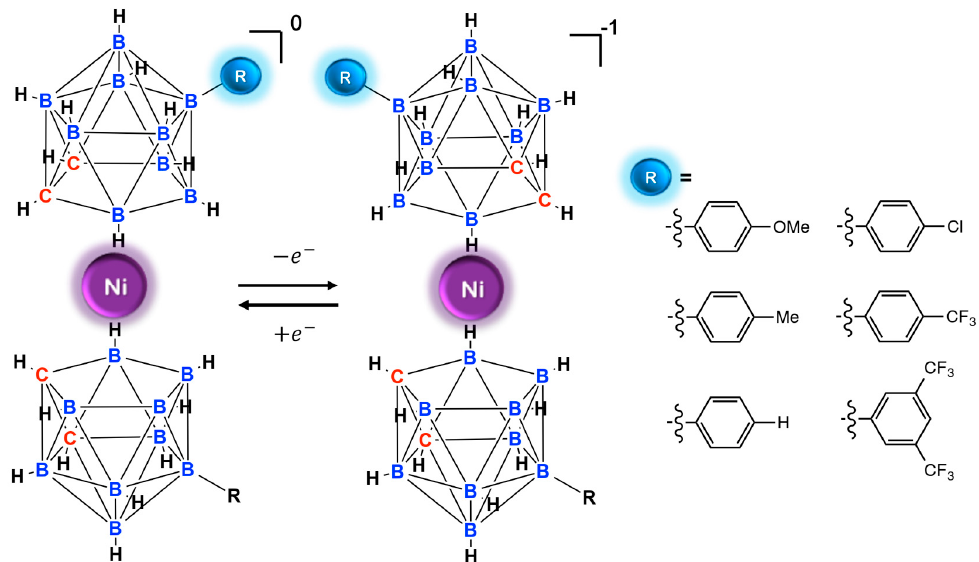
Figure 10. Structure of Ni-bis(dicarbollide) mediators [199,201]. Adapted from [201], with permission from